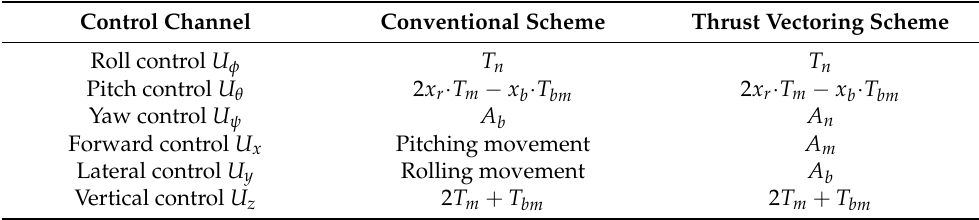
Table 1. Control allocation for different schemes in the VTOL phase.